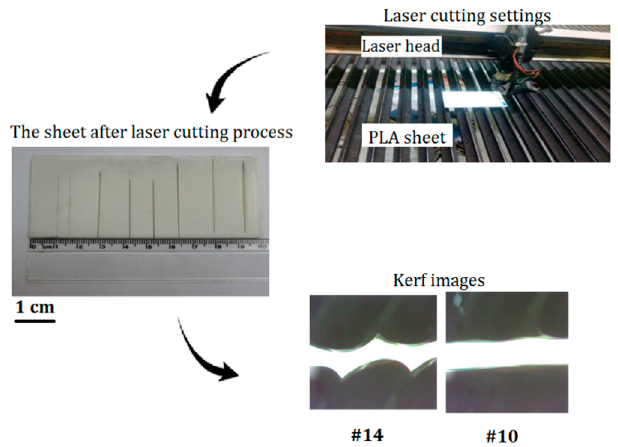
Figure 5. Laser cutting process and quality of some cutting kerf and surface.